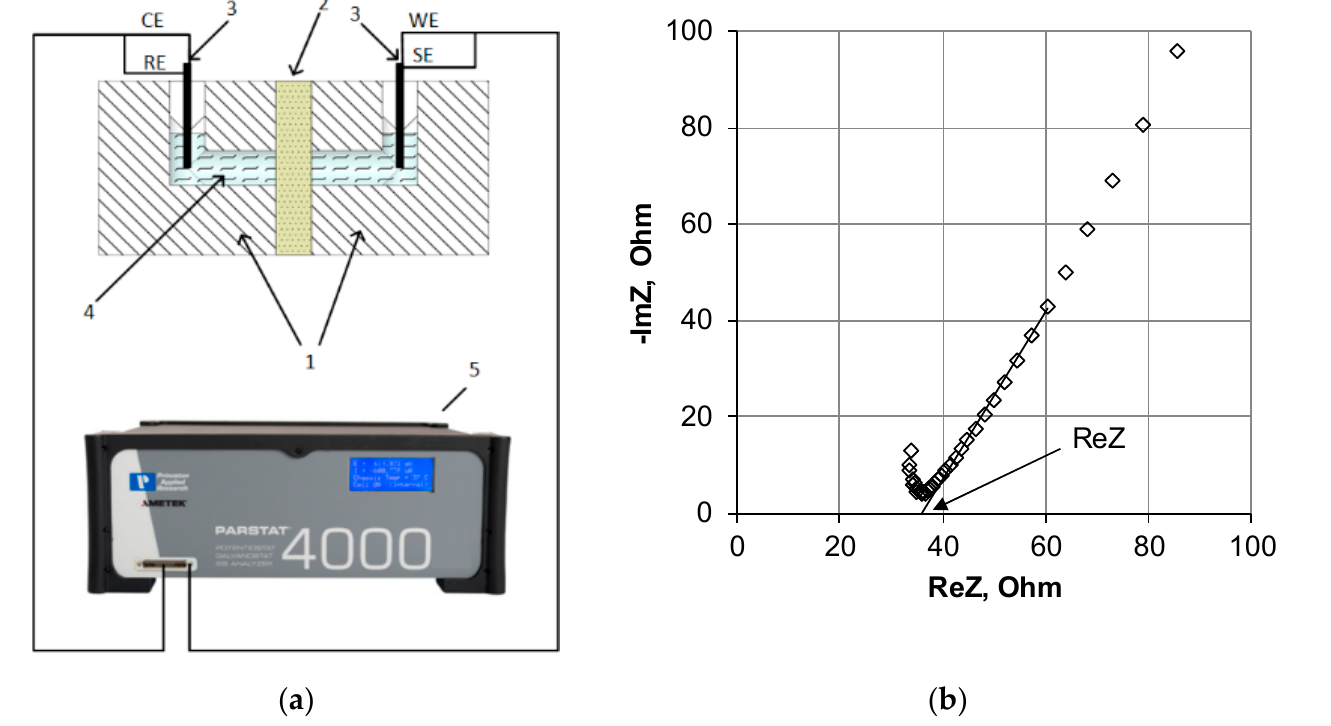
Figure 3. The scheme of the mercury-contact cell ( a ) and a frequency spectrum example of the electrochemical impedance ( b ). 1—mercury-contact cell, 2—studied membrane, 3—platinum electrodes, 4—mercury, and 5—impedance meter.